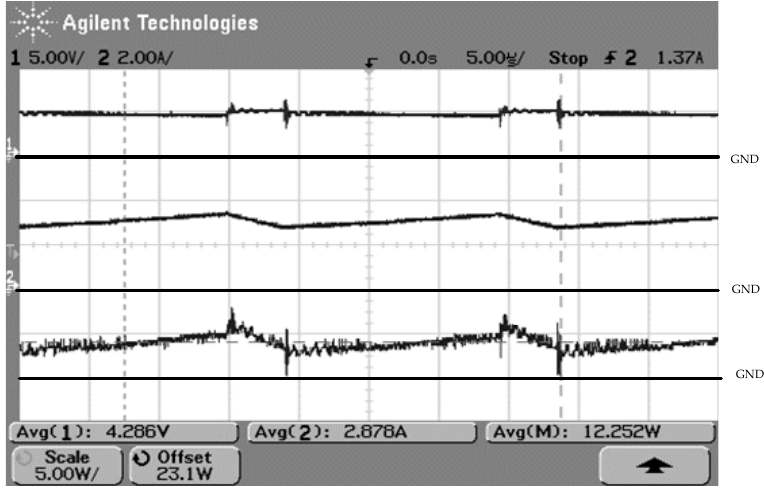
Figure 17. Input characteristics of the proposed boost converter with f s = 50 kHz. ( Top Trace ) Input Voltage (5 V/div); ( Middle Trace ) Input Current (2 A/div); ( Bottom Trace ) Input Power (2 W/div).